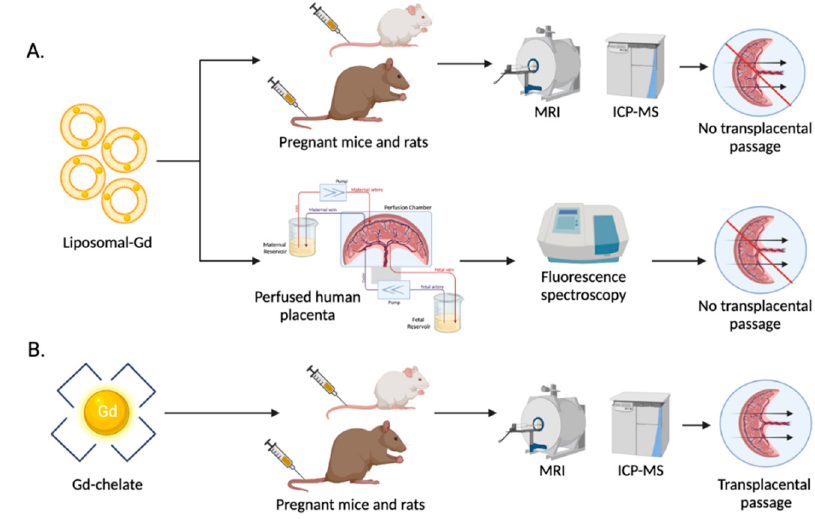
Figure 4. Comparison between liposomal-Gd [95,101] ( A ) and conventional Gd-chelate [101] ( B ) transplacental passage.